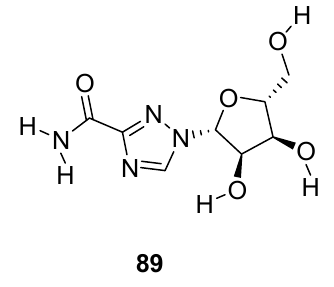
Figure 3. Structures of antiviral drugs 89–91.